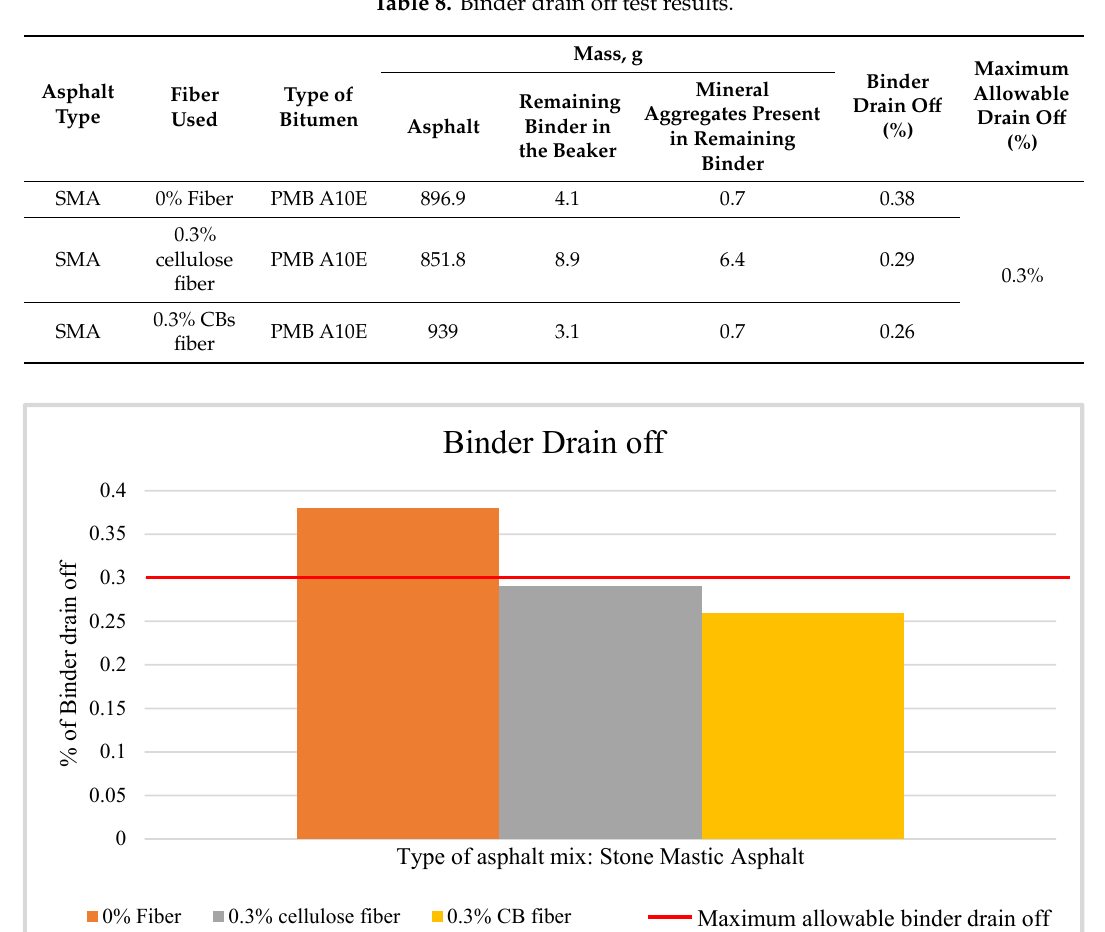
Table 8. Binder drain o ff test results.